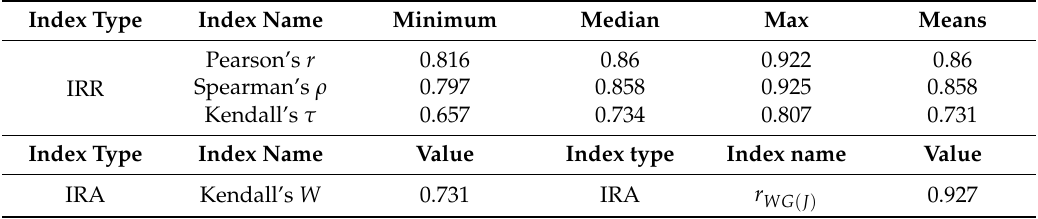
Indices of Intra-Rater Reliability (IRR) and Intra-Rater Agreement (IRA) for the Geo-Terminology Relatedness Dataset